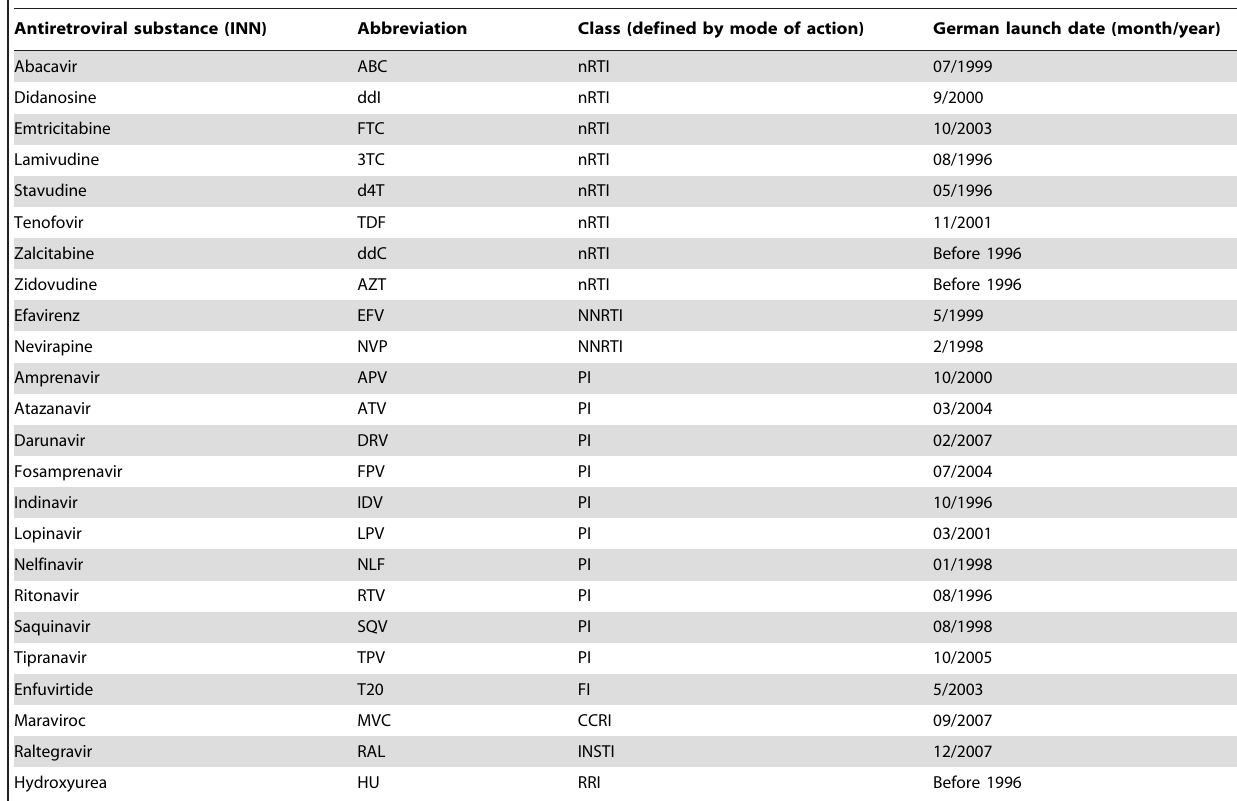
Table 1. Licensed antiretroviral drugs and their assigned substance classes.